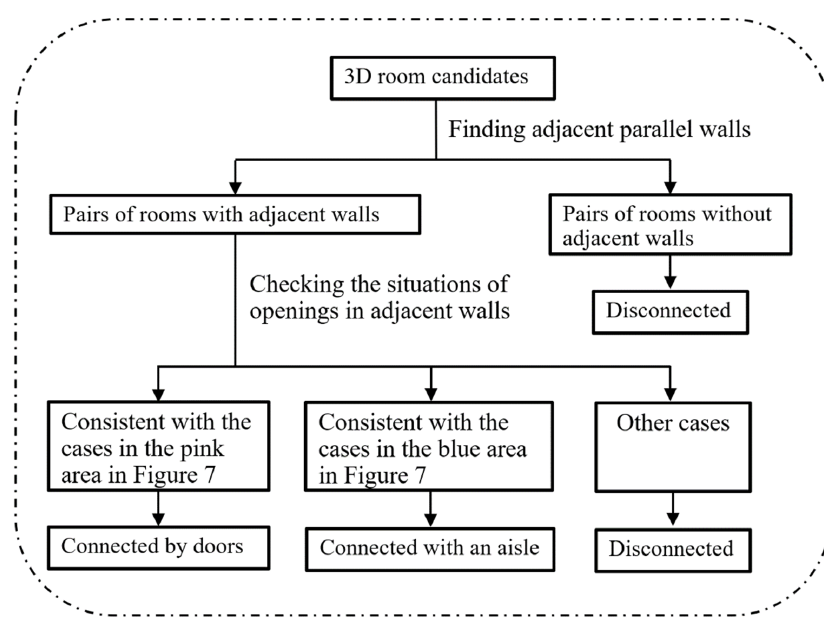
Figure 6. Flowchart for the room connection analysis.